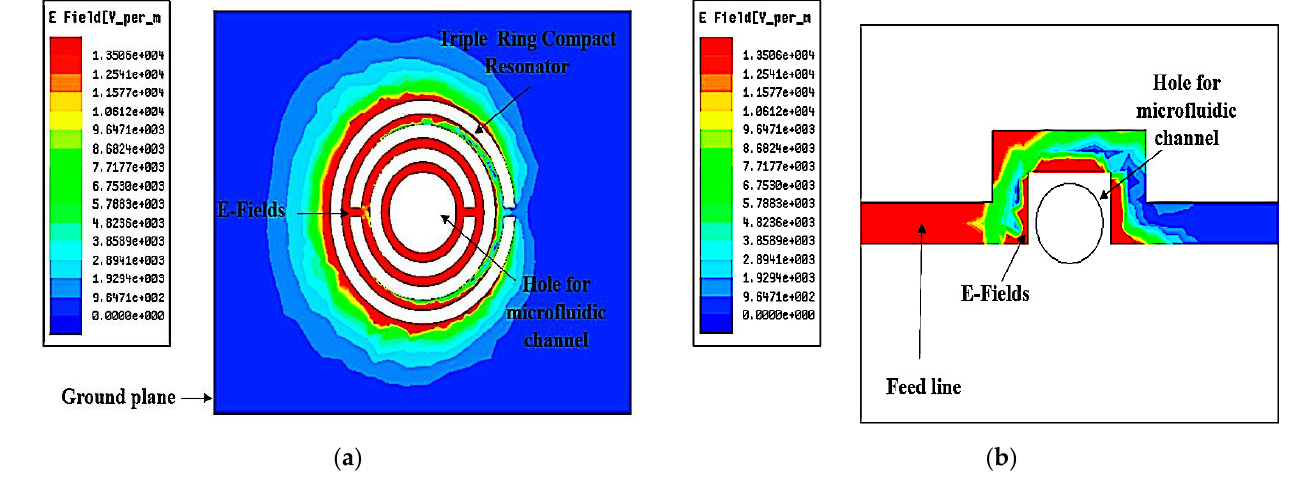
Figure 4. Distribution of TR curve-feed sensor electric fields; ( a ) ground plane, ( b ) feed line.